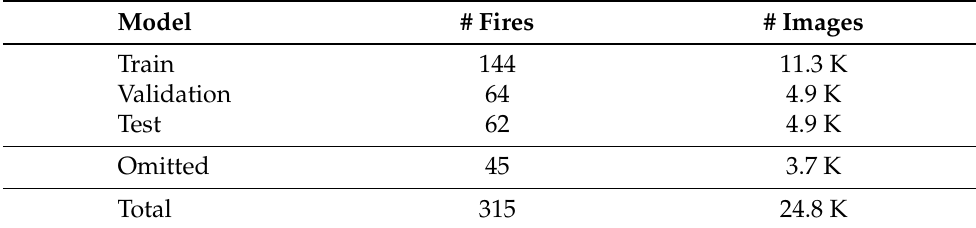
Table 1. Cross-validation splits of the FIgLib